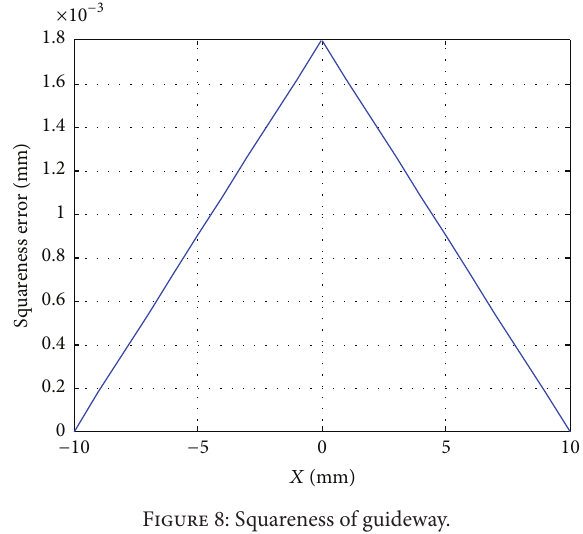
Figure 8: Squareness of guideway.